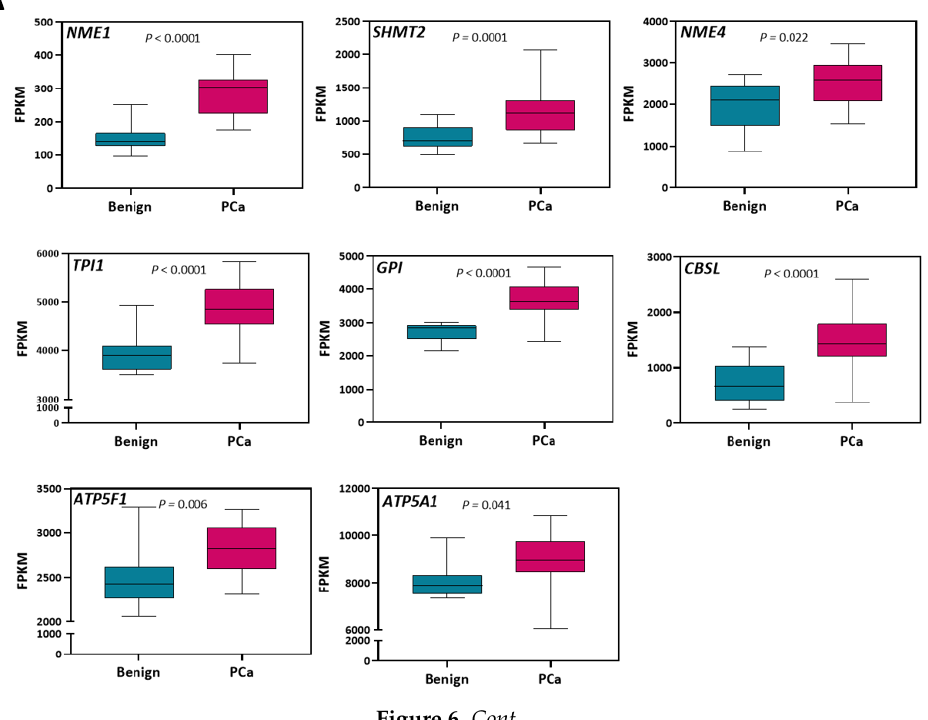
Figure 6. Expression of enzymes linked to metabolites stimulated by succinate in transcriptomic cohorts of prostate cancer patients. ( A ) Boxplots representing Fragments Per Kilobase Million (FPKM) values for expression of significantly upreg- ulated genes in prostate cancer (PCa) (pink) vs. the paired benign (blue) biopsies ( N = 16, [25]). Data are presented as